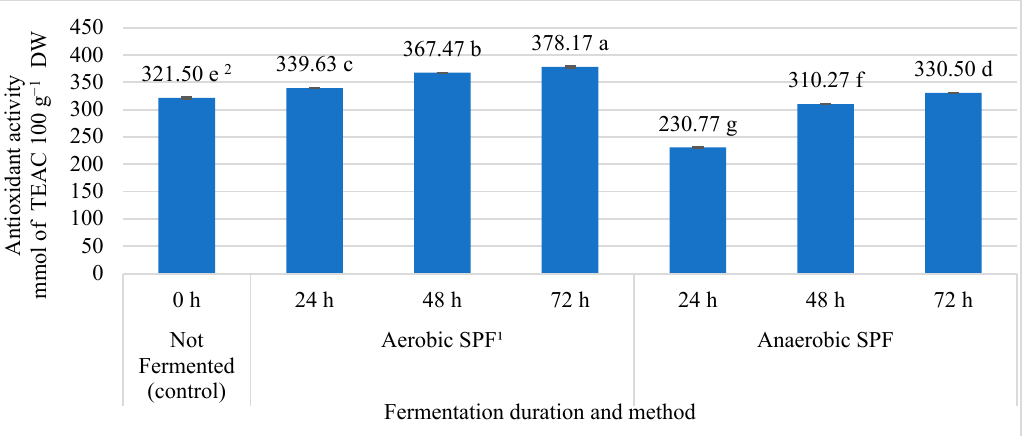
Figure 1. The influence of solid-phase fermentation on antioxidant activity in fireweed leaves. 1 SPF — solid-phase fermentation. 2 Averages marked by different small letters are statistically significantly different at p < 0.05.